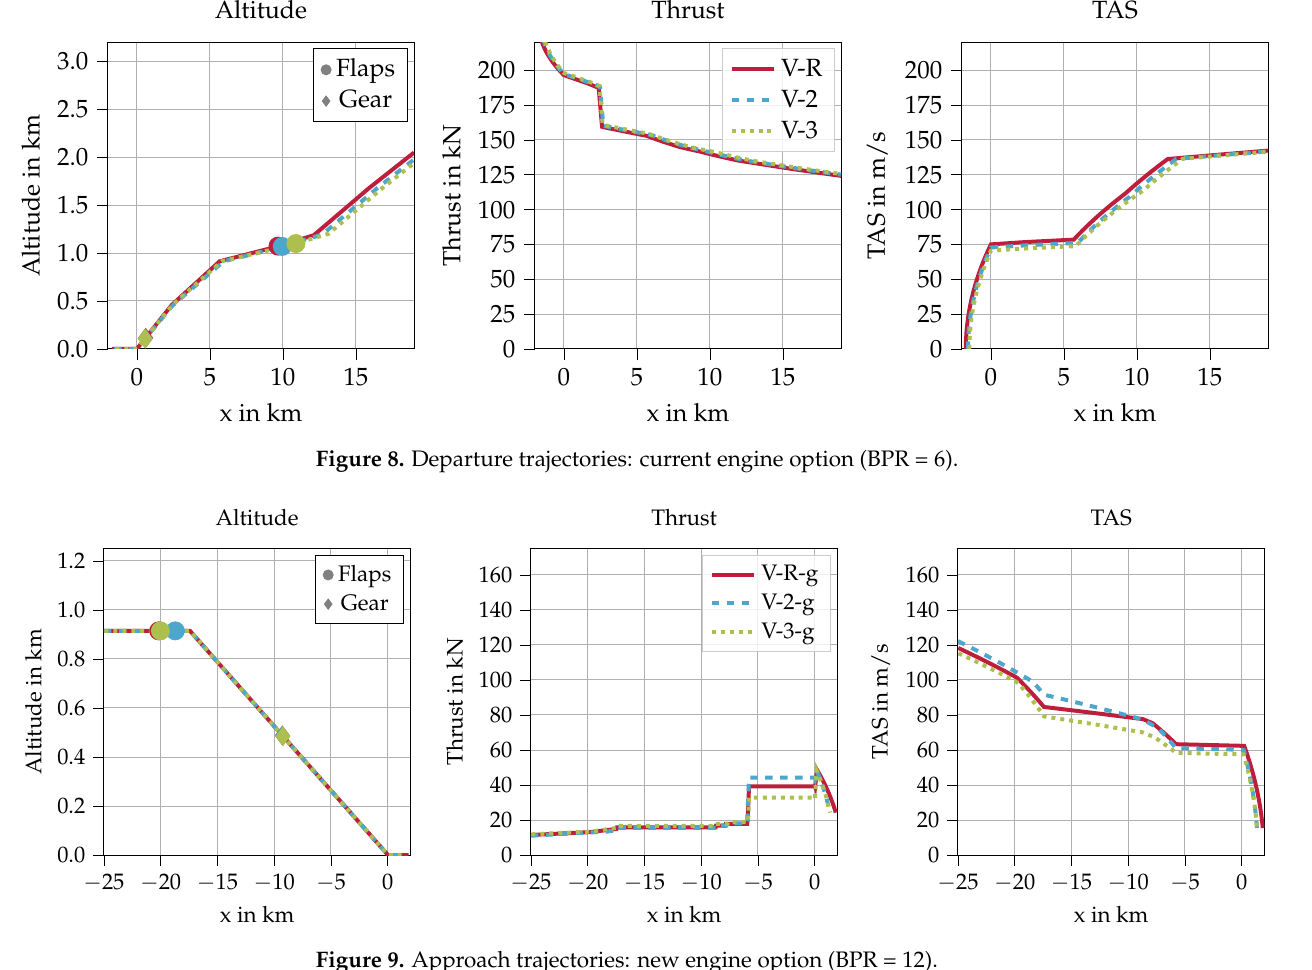
Figure 9. Approach trajectories: new engine option (BPR = 12).